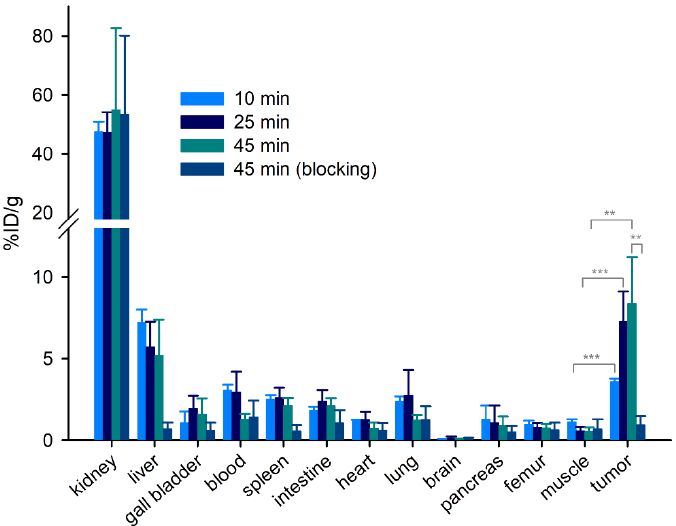
Figure 5. Biodistribution data (%ID/g tissue) of [ 68 Ga] 56 obtained from HT-29 tumor-bearing mice. Given are mean values ± SD (n = 4). Blocking data were obtained by co-injection of 48 (560–700 nmol/mouse). Statistical analysis of differences between tracer accumulation in the tumor of unblocked and blocked animals was performed by an unpaired two-tailed t -test ( p <0.05 was considered statistically significant). ** p <0.01. *** p <0.001. Table 3. Ex vivo biodistribution data and tumor-to-muscle ratios of [ 68 Ga] 56 obtained from HT-29 tumor-bearing mice a . Uptake (%ID/g) at Given Times p.i. Tissue